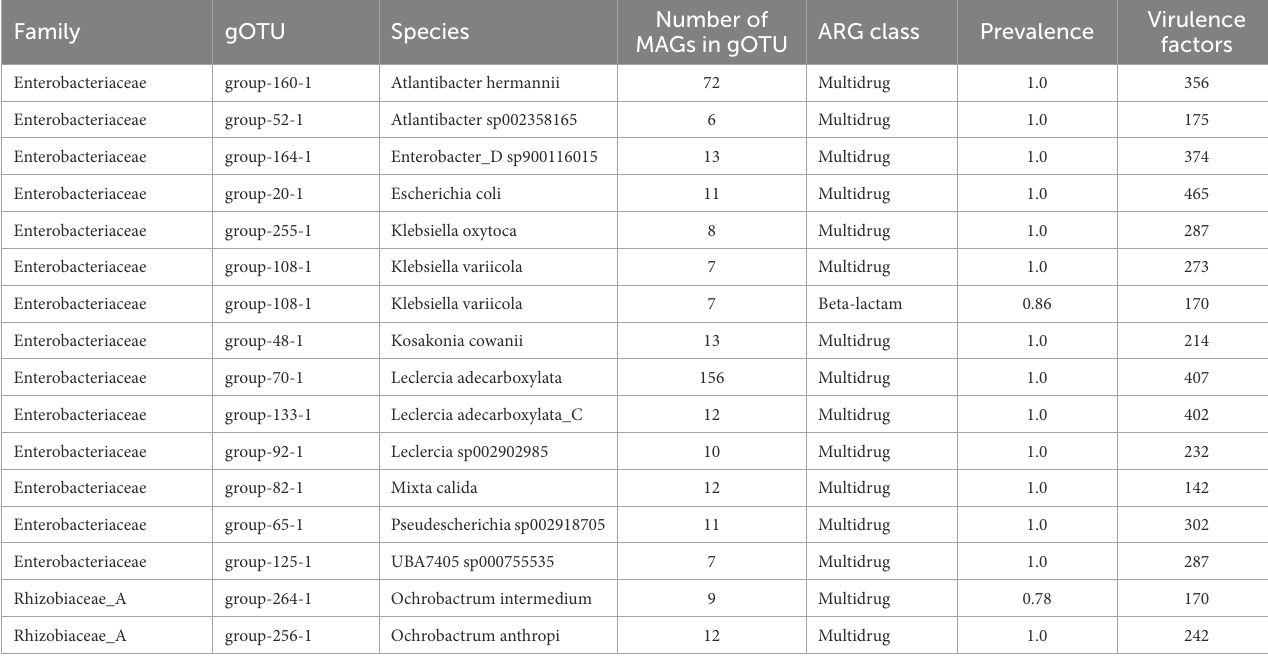
TABLE 2 List of the gOTUs that had more than 100 virulence factors co-occurring with ARGs in ARG classes that were widespread within the gOTU, i.e., ARG class prevalence equal to or higher than 0.75 (Figure